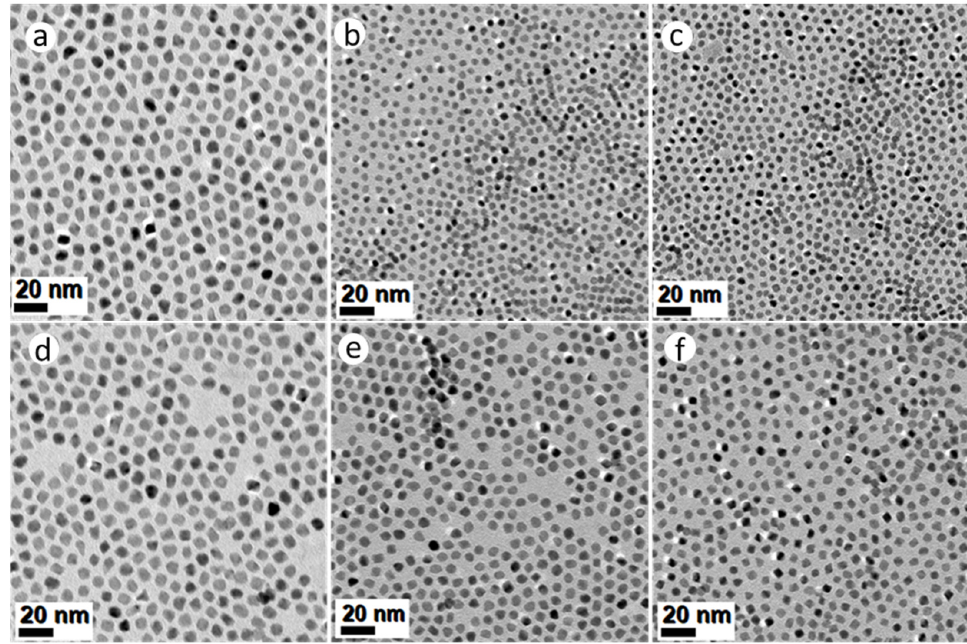
Figure 3. TEM BF images of PtNi, PtCo and Pt(NiCo) alloy NPs synthesized via simultaneous reduction of Pt(acac) 2 and non-noble organometallic precursors: ( a ) Ni(Ac) 2 , ( b ) Co(Ac) 2 and ( c ) Ni(Ac) 2 + Co(Ac) 2 ; ( d ) Ni(acac) 2 , ( e ) Co(acac) 2 and ( f ) Ni(acac) 2 + Co(acac) 2 in the presence pure amine surfactant OAm using the reductant Mo(CO) 6 . All the corresponding PXRD lines of these PtNi, PtCo and Pt(NiCo) alloy NPs displayed single solid solution phases.